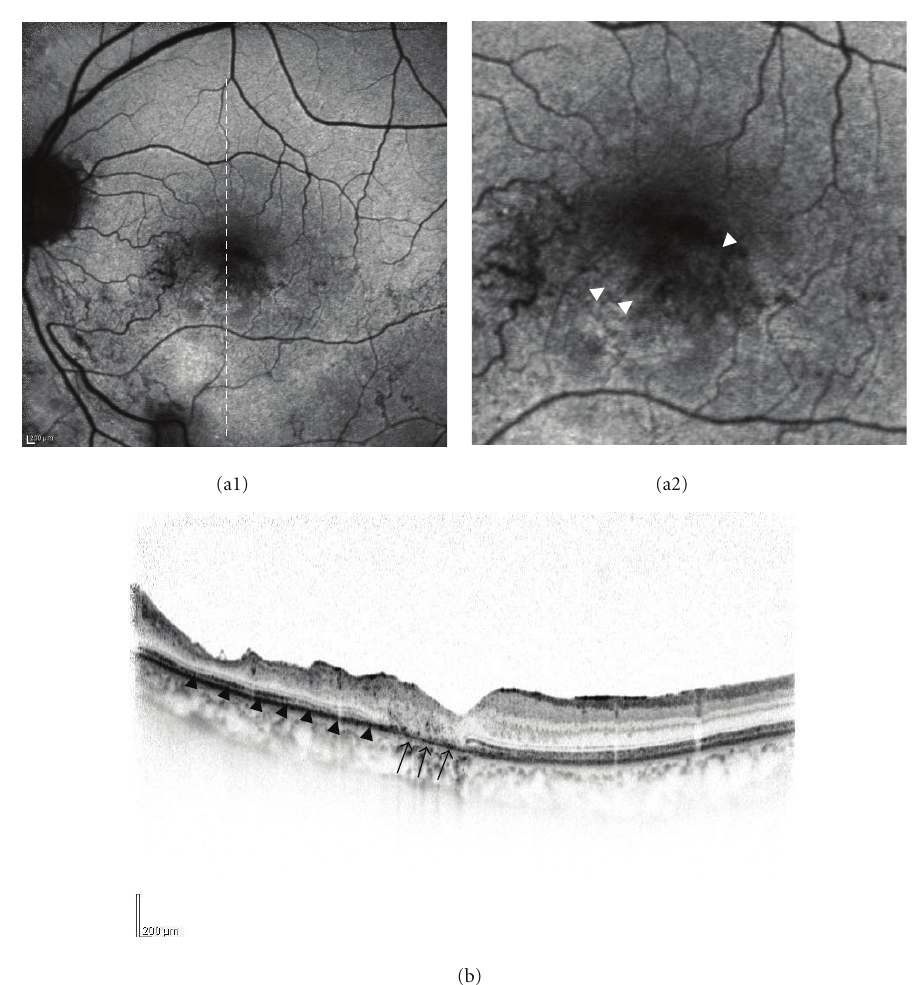
Figure 4: Fundus autofluorescence and OCT images for Patient 4 (a 67-year-old man). Retinal bleeding in the inferotemporal area was resolved 19 weeks after intravitreal bevacizumab injection. (a1) Fundus autofluorescence showed hyperautofluorescence in the inferotemporal area. (a2) High magnification image of the fovea. Hyperautofluorescence appeared in the corresponding area of cystoid macular edema (white arrowheads). The OCT image (b) showed a defect of the inner/outer segments at the fovea (arrows) and thinning of the retina (black arrowheads) corresponding to the area that showed di ff use hyperautofluorescence after resolution of edema (right). The dashed line indicates the OCT scanning